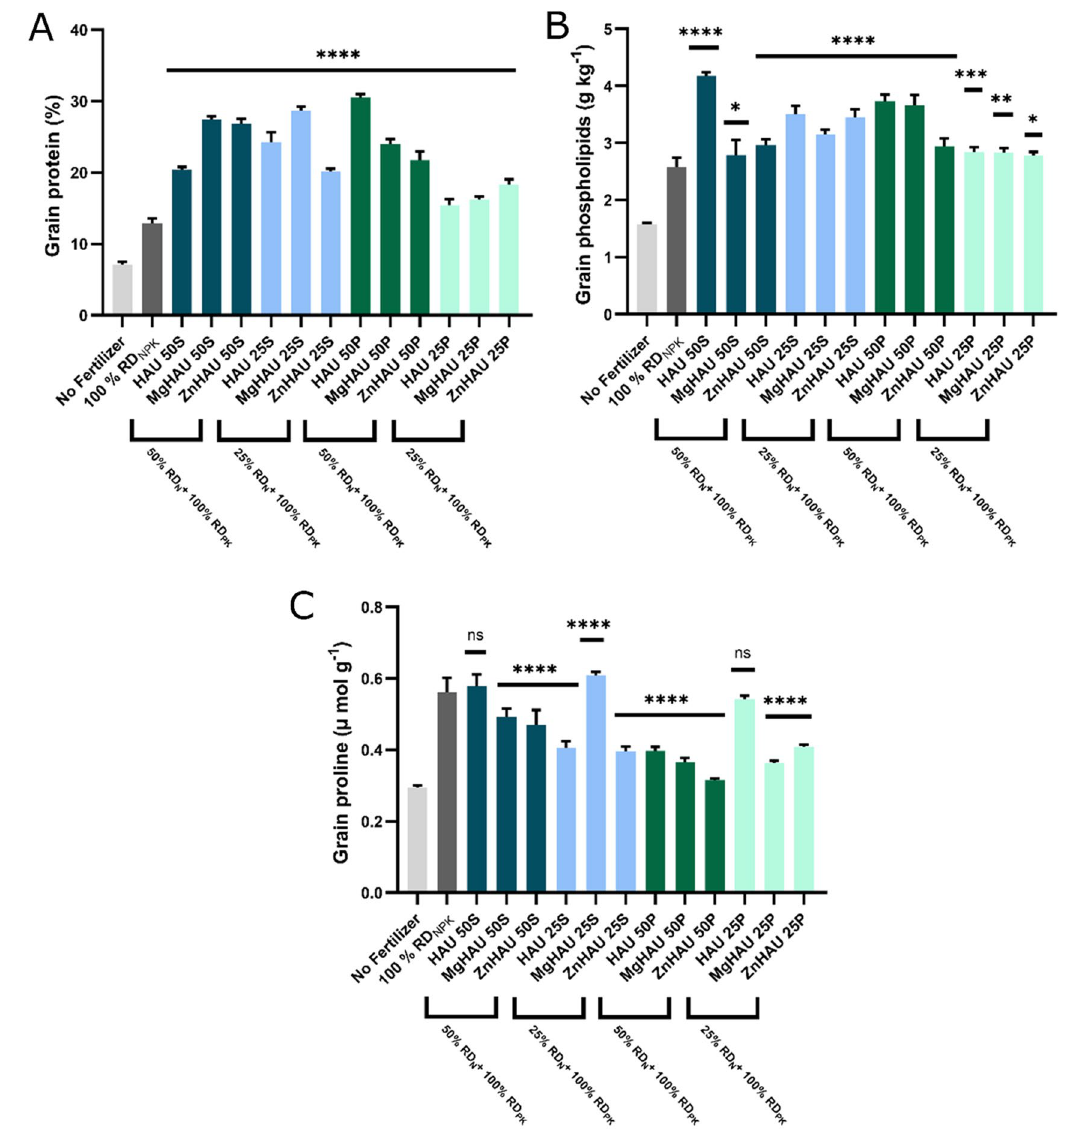
Figure 6. Wheat grain quality parameters evaluated after harvesting. ( A ) Protein, ( B ) Phospholipids, and ( C ) Proline were evaluated for the wheat grains after harvesting in the wheat crop treated with a quarter and half dose of nitrogen as nanohybrids (suspension and pellet), full dose of nitrogen as urea (as control), and without fertilizer (no fertilizer). All the nanohybrid treatments (HAU: Hydroxyapatite-urea, MgHAU: Mg-doped hydroxyapatite-urea, and ZnHAU: Zn-doped hydroxyapatite-urea) were compared with the control or 100% RD NPK treatment. The values are provided as mean ± standard deviation, and statistical significance was calculated by one-way ANOVA with Dunnett’s multiple comparison test. The letters ‘*’, ‘**’, ‘***’, and ‘****’ represent ‘p < 0.05’, ‘p < 0.01’, ‘p < 0.001’, and ‘p < 0.0001’, respectively and ‘ns’ represents ‘not